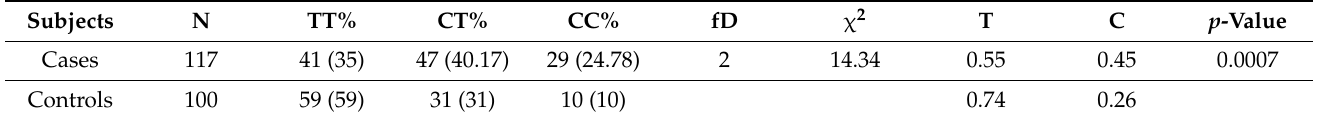
Table 8. ACE2 rs4240157 T > C gene polymorphism in COVID-19 patients and controls.